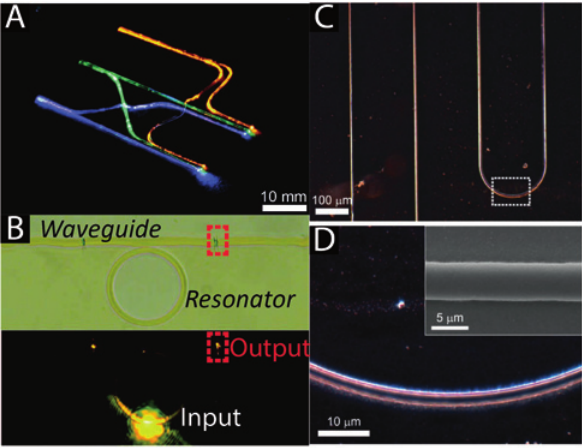
Figure 13: Optical waveguides written using inkjet printing. (A) Optical waveguide network with three LEDs, demonstrating the low crosstalk between waveguides. Reprinted with permission from Ref. [180]. (B) Microscope images of a microring resonator and a waveguide, demonstrating the guiding and coupling of the input laser beam. Reprinted with permission from Ref. [181]. (C-D) Images of a printed silk waveguide with SEM inset in (D). Reprinted with permission from Ref. [169].